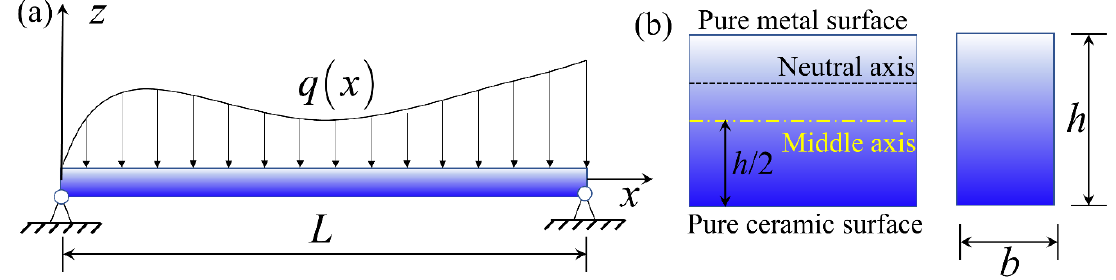
Figure 1. Illustration of FGM nanobeam model: ( a ) hinged-hinged nanobeam under distributed loads; ( b ) physical neutral surface and geometry middle surface.